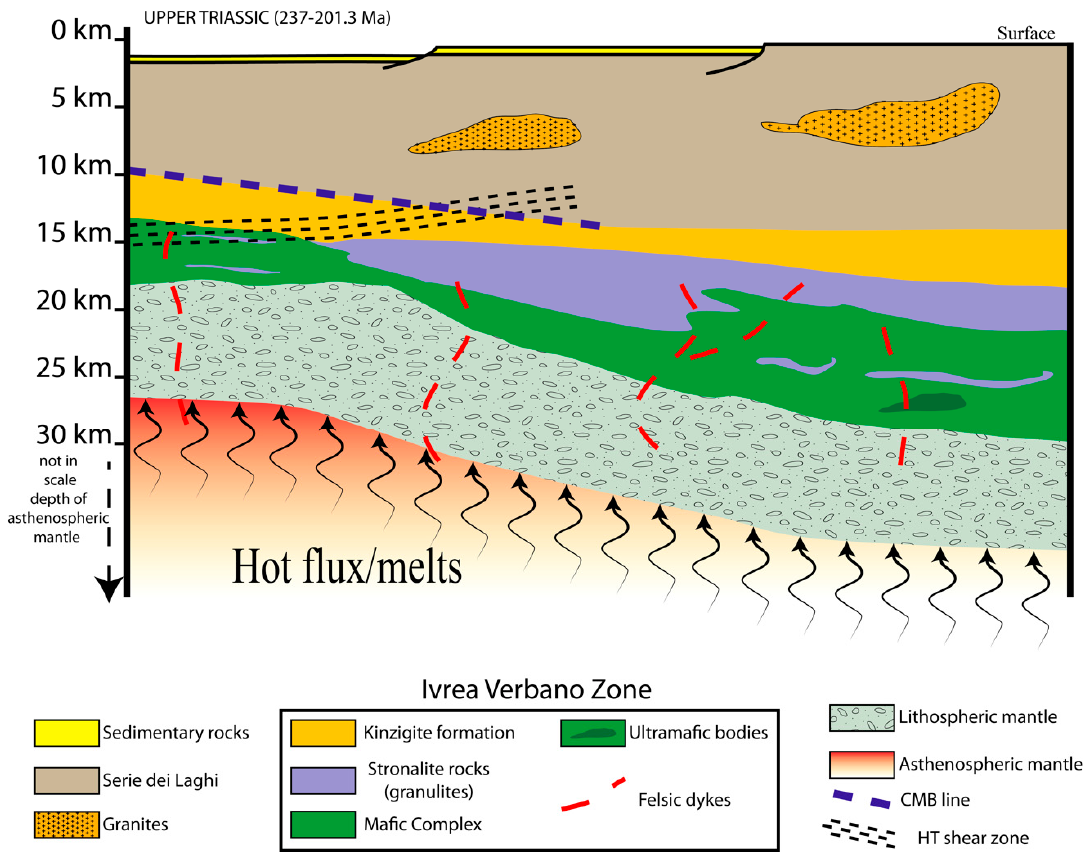
Figure 12. Schematic sketch of the IVZ lithospheric section at Upper Triassic showing the intrusion of felsic dykes in the middle/lower crustal levels. Black arrows indicate the hot flux/melt upraising from asthenosphere in an extensional tectonic regime.